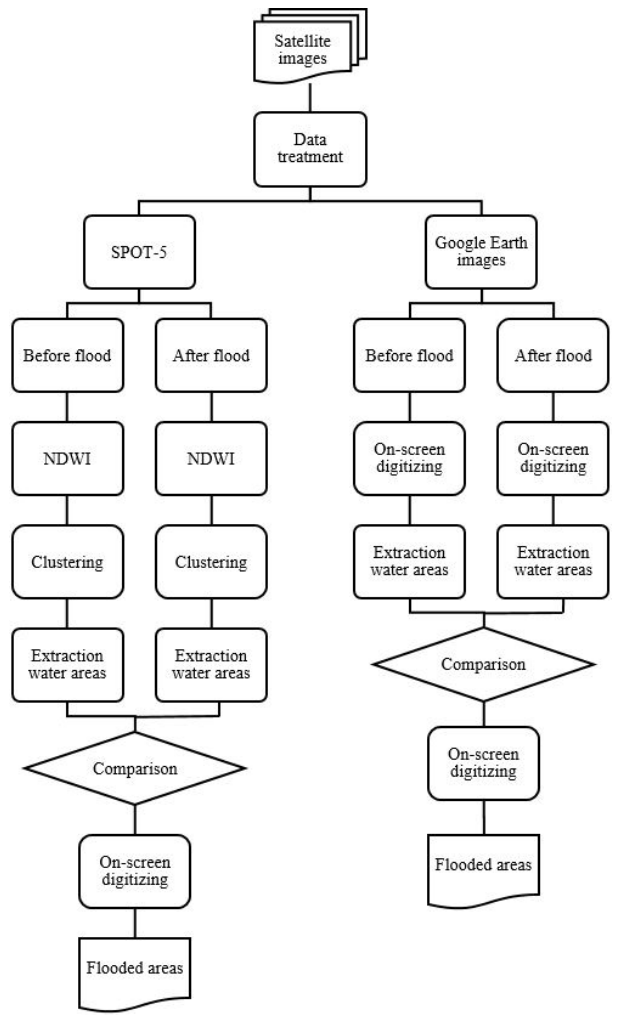
Figure 3. Framework for retrieving flooded areas by remote sensing